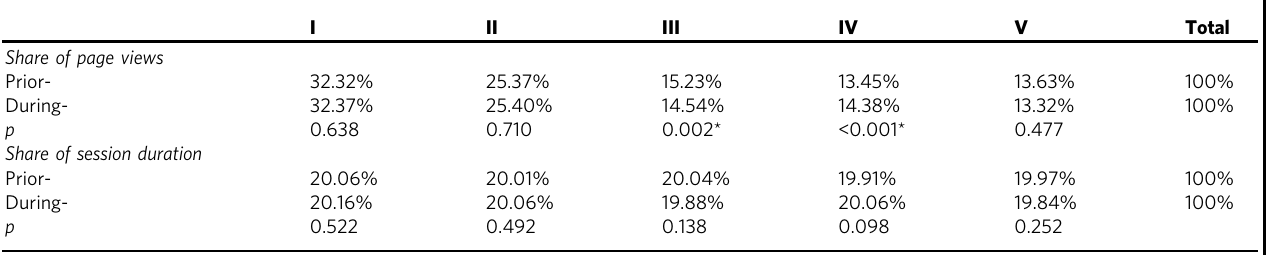
Table 3 Share of page views (above) and session duration (below) of the respective areas of interest during the total investigated period prior- vs. after the beginning of the lockdown (Germany, Austria, and